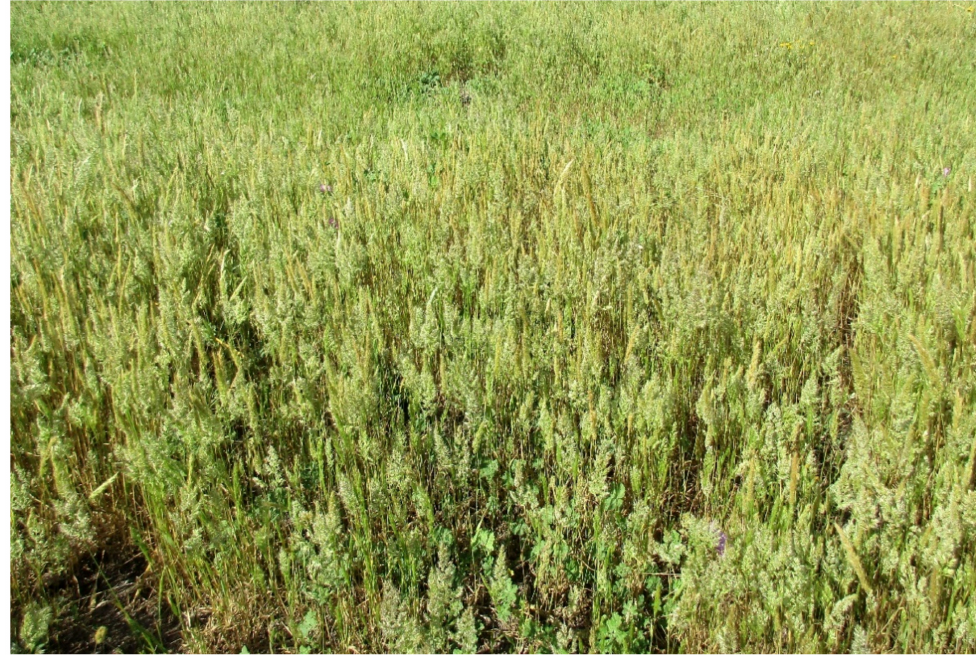
12. Sisymbrietea Gutte et Hilbig 1975: anthropogenic vegetation of animal shelters and disturbed ruderal sites (Figure 30).